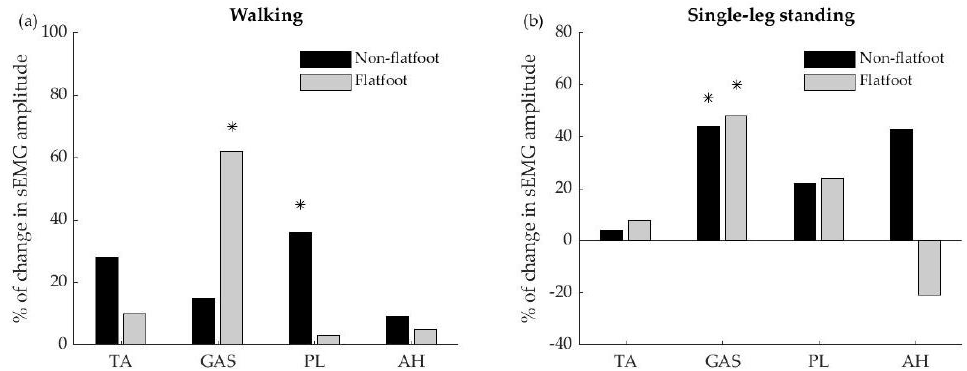
Figure 4. Changes of muscle-activation level during ( a ) walking and ( b ) single-leg standing for non- flatfoot and flatfoot groups. * Significant differences between pretest and posttest. TA, tibialis ante- rior; GAS, gastrocnemius; PL, peroneus longus; AH, abductor hallucis. The median frequency of the tibialis anterior in flatfoot group was significantly de- creased (from 116 to 106 Hz) after 6 min of fast walking ( p < 0.001), further confirming that the tibialis anterior was likely most fatigued (Figure 5). Interestingly, the median fre- quency of the abductor hallucis in the flatfoot group increased (from 189 to 215 Hz) after 6 min of fast walking ( p < 0.001).